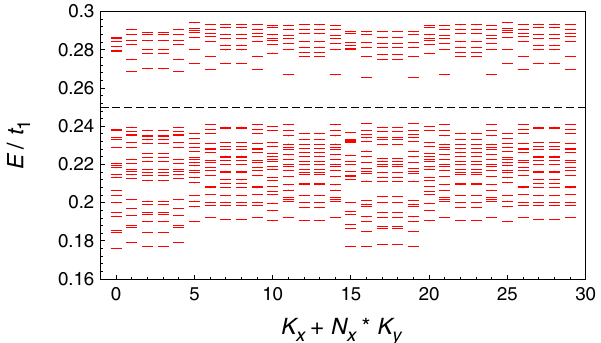
FIG. 6. Low-energy spectrum for N ¼ 9 , N x ¼ 5 , N y ¼ 6 . The number of states below the dashed line is 19 in sectors where mod 3 ¼ 0 ; 18 in other sectors, as expected from the analytical K y results. The total counting matches the one expected for Laughlin quasihole states. The counting for each momentum sector is given by the generalized Pauli principle and the 2-dimensional to 1-dimensional unfolding presented in the next